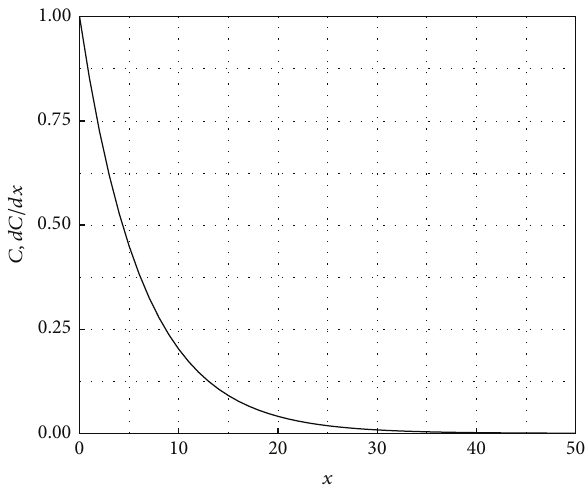
Figure 6: Normalized solutions of the mean concentration and its gradient for a continuous plane source, only considering the advection term and a 0th order kinetics ( 𝑈 = 5 ms −1 , 𝑚 𝑖 = 0.1 kg s −1 , and 𝑘 = 0.8 ∗ 10 3 molm −3 s −1